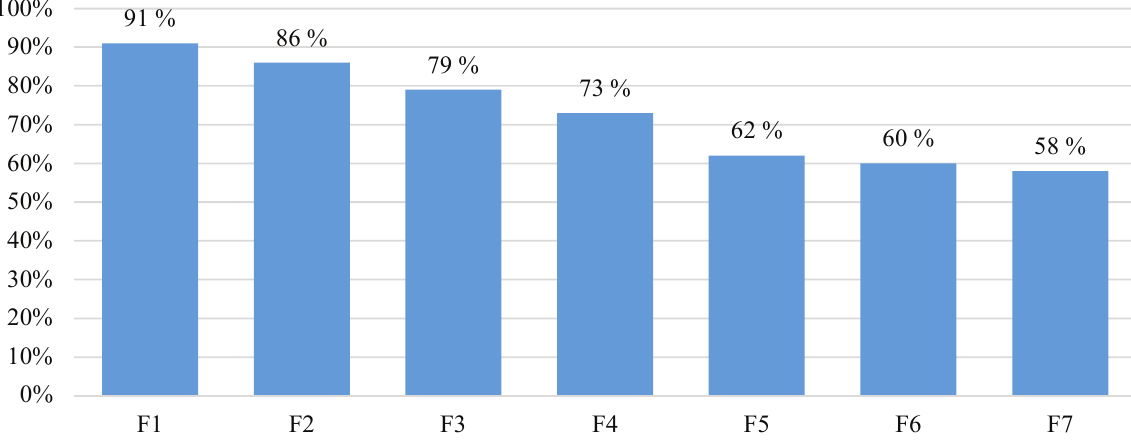
Fig. 9. The main directions of promoting the development and improvement of the educational brand: F1 – continuous improvement of educational services, F2 – intensification of international cooperation, F3 – active involvement of practitioners and scientists, F4 – active involvement of higher education in scientific, volunteer and cultural life, F5 – building relations with employers, F6 – intensifying the use of channels for dissemination of information about